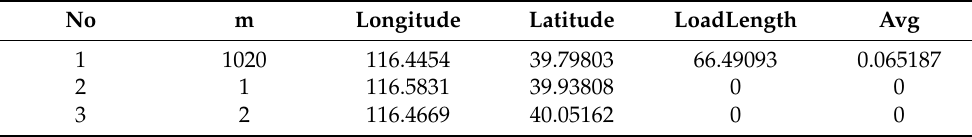
Table 12. The clustering results of HF_DBSCAN for the DS2 dataset.